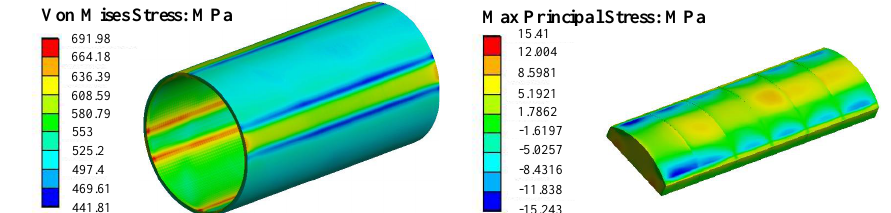
Figure 10. The calculation results of fluent and static stress coupling.